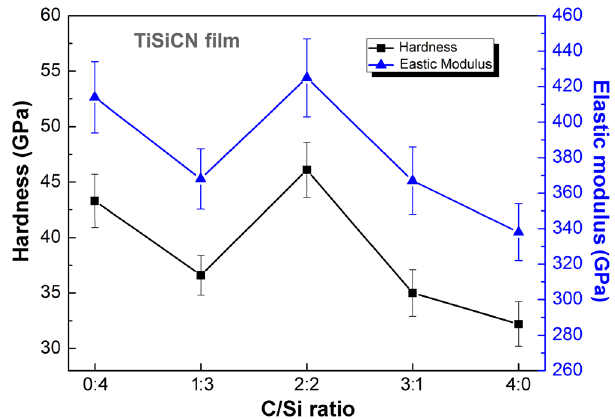
Figure 5. Variation of the hardness and elastic modulus of the TiSiCN nanocomposite films with the change of the C/Si content ratio. The hardness and elastic modulus reach the maximum values with the C/Si content ratio of